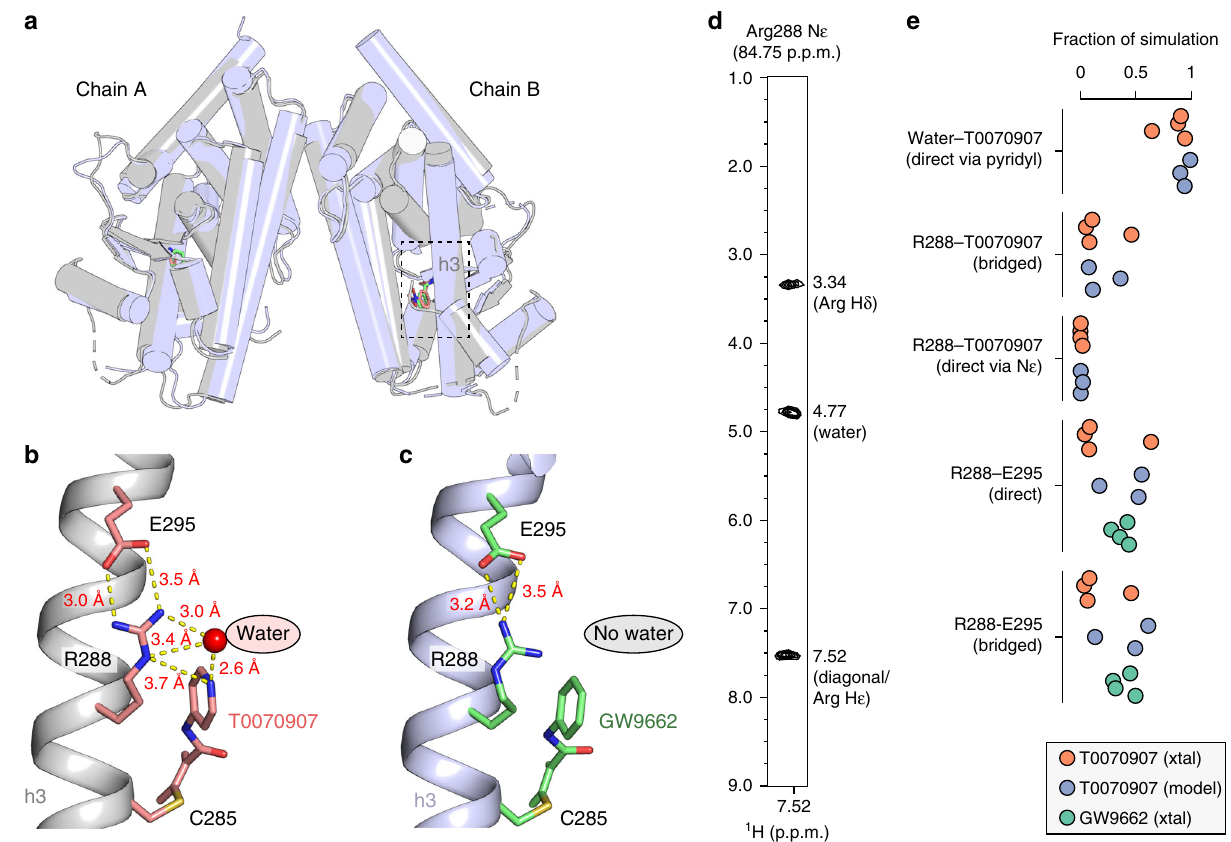
Fig. 3 A water-mediated hydrogen bond network connects Arg288 to T0070907. a Overall structure of T0070907-bound PPAR γ LD (PDB code 6C1I; gray) and overlay with GW9662-bound crystal structure (PDB code 3B0R; blue). b A water-mediated hydrogen bond network in the T0070907-bound crystal structure (chain B is shown) links the pyridyl group in T0070907 to the R288 side chain, which forms a bipartite hydrogen bond with the E295 side chain. c The GW9662-bound crystal structure (chain B is shown) lacks the R288-ligand hydrogen bond network but contains the R288-E295